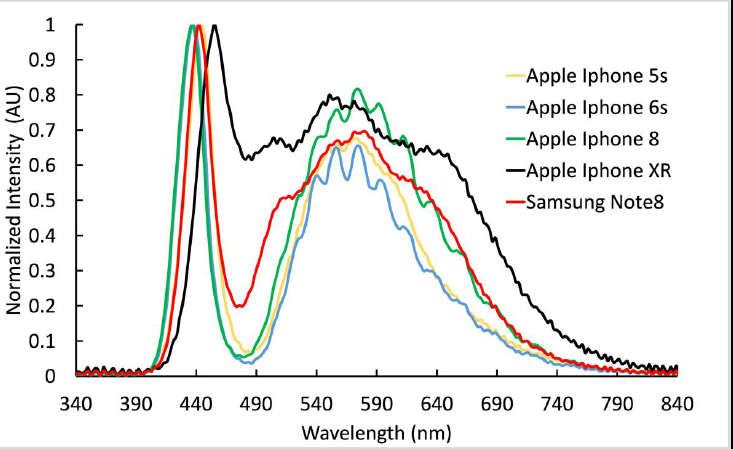
Figure 7. Normalized emission spectra of tested smartphones. Flash spectra of Apple iPhone 5s (yellow), iPhone 6s (blue), iPhone 8 (green), iPhone XR (black), and Samsung Note 8 (red) were normalized to their respective highest values for ease of comparison since each model required a custom 3D-printed holder. We also evaluated the spatial variability of camera sensitivity using a control LFA cartridge containing a uniformly phosphorescent film (FDC 2847 RTape GlowEFX). The control cartridge was pre-flashed with a diffuse light source and imaged in our attachment with an iPhone 8 Plus. The image was then analyzed using ImageJ [33]. The resulting in- tensity profile showed that the sensitivity in the middle field of view is about 10% greater than at the outside edges (Figure 8). This is due to the pincushion distortion introduced by the lens in our attachment.